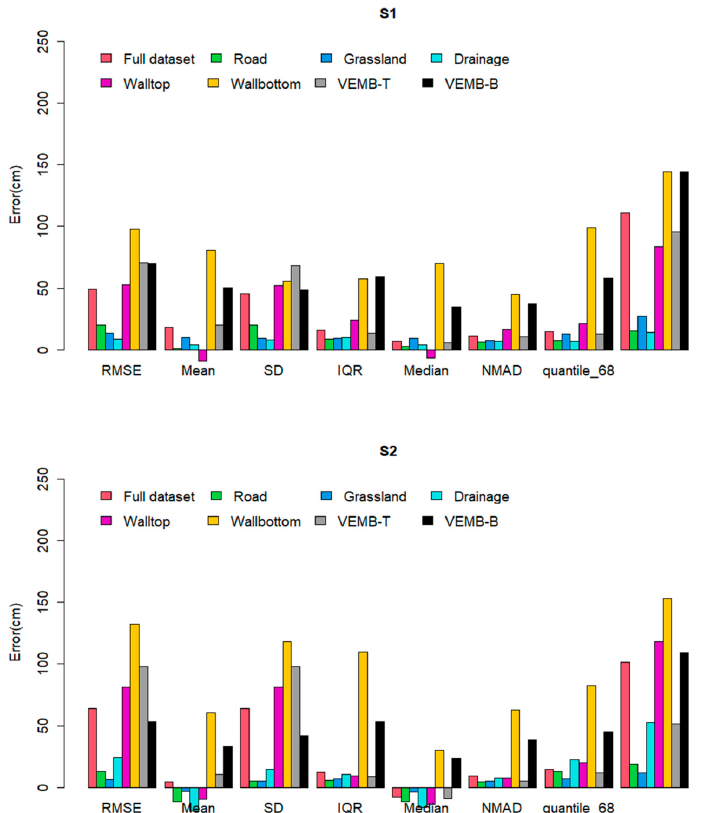
Figure 9. Plot summarizing traditional and robust statiscal metrics (Table 3) for S1 and S2 (for all classes combined as well as per land class and microtopographic feature) when compared to Ground Control Point measurements. RMSE denotes root mean squared error. IQR stands for interquartile range. NMAD stands for normalized median absolute deviation. quantile_68 stands for 68.3% quantile. quantile_95 stands for 95% quantile. VEMB-T stands for the top of the vegetated embankment and VEMB-B stands for vegetated embankment.